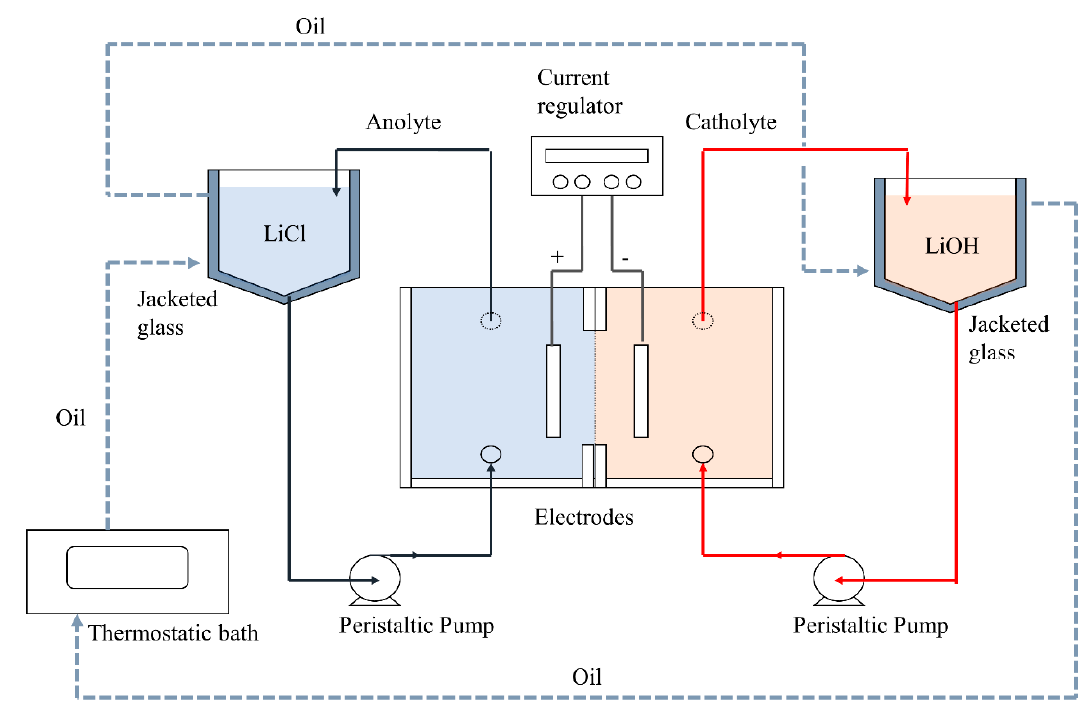
Figure 3. Schematic diagram of lab scale process to obtain LiOH by membrane electrodialysis.